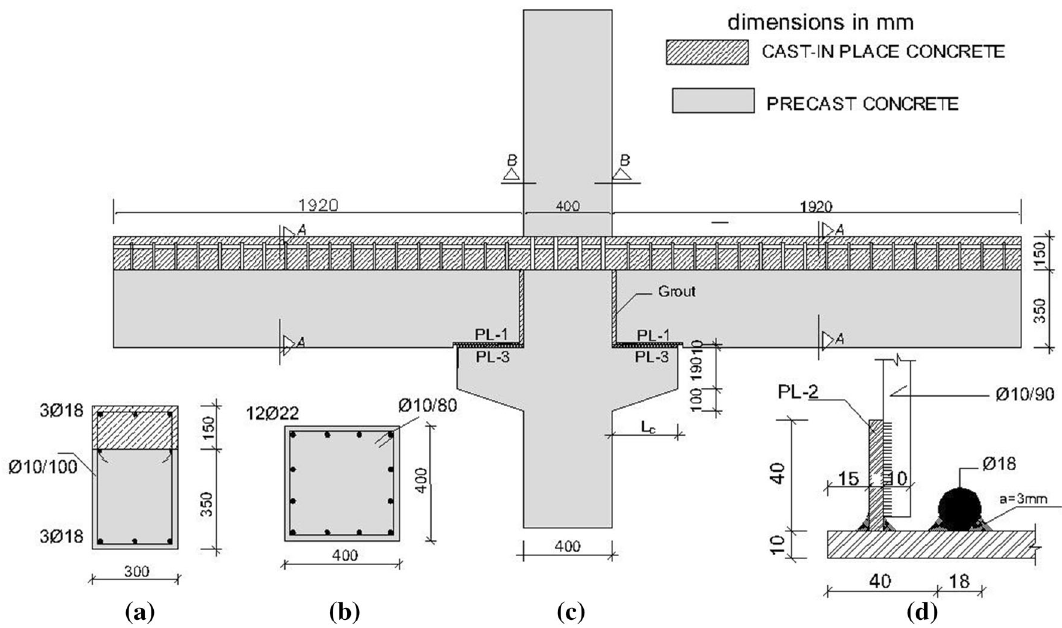
Fig. 5 a Beam, b column cross-sections, c front view and dimensions of the hybrid beam-column connections, and d welding detail of beam bottom longitudinal rebars to beam support plate (PL-1) and stirrups to vertical plates (PL-2) for SP1, SP2 and SP3